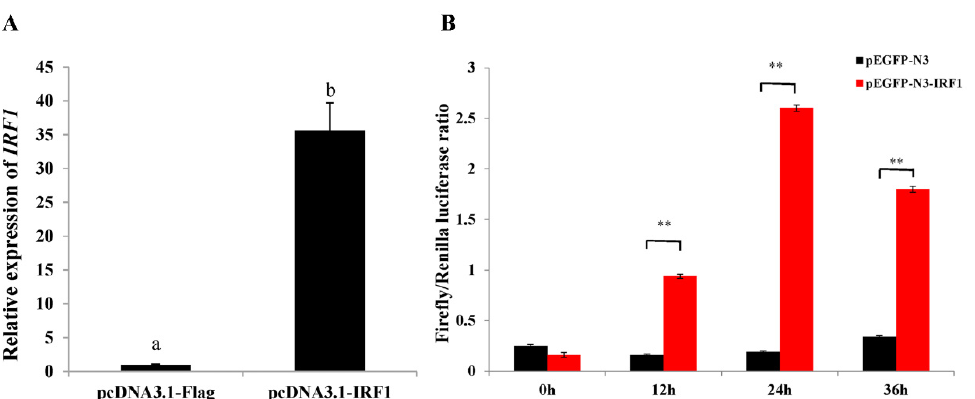
Figure 5. Ectopic expression of ToIRF1 increased the expression of the ToIFN α 3 gene. ( A ) GPS cells were transfected with ToIRF1 and empty vector, and then cells were collected for RNA extraction and qRT-PCR. ( B ) Dual-luciferase activity was driven by the ToIFNa3-p1 sequence upon the transfection of pEGFP-ToIRF1 and pEGFP-N3 into GPS cells. All values are presented as the means ± SD ( n = 3). Asterisks indicate that the values are significantly di ff erent from the individual controls (* p < 0.05, and ** p <